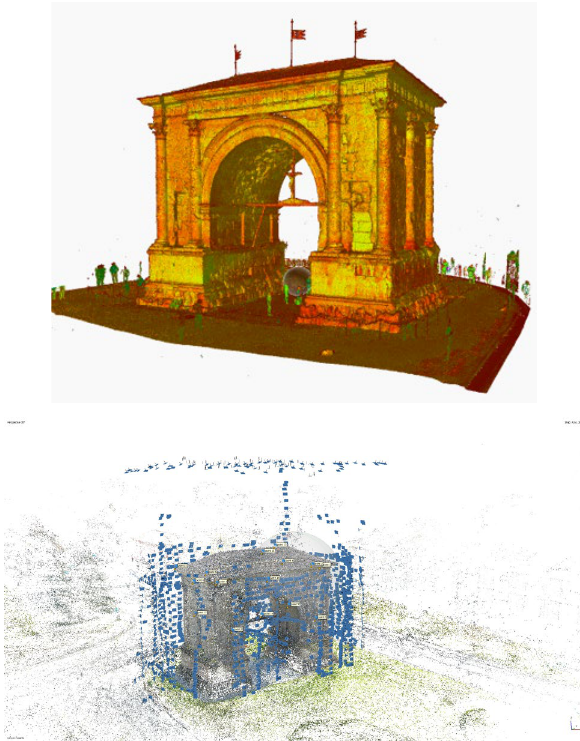
Figure 1: Point cloud of the Arch, from laser scanner (top), from UAV photogrammetry (bottom)